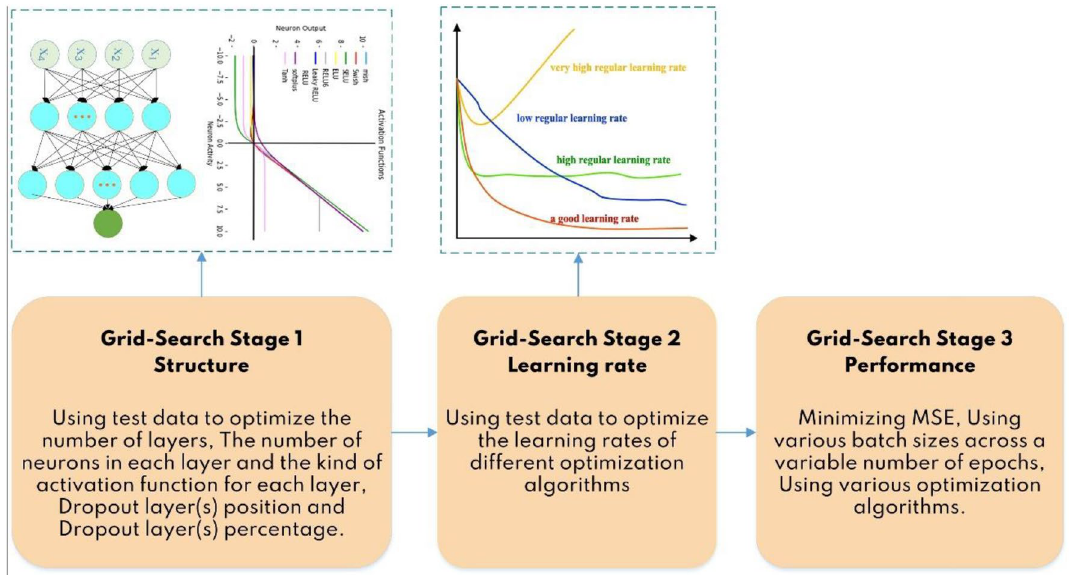
Figure 7. Different stages for optimizing the ANN